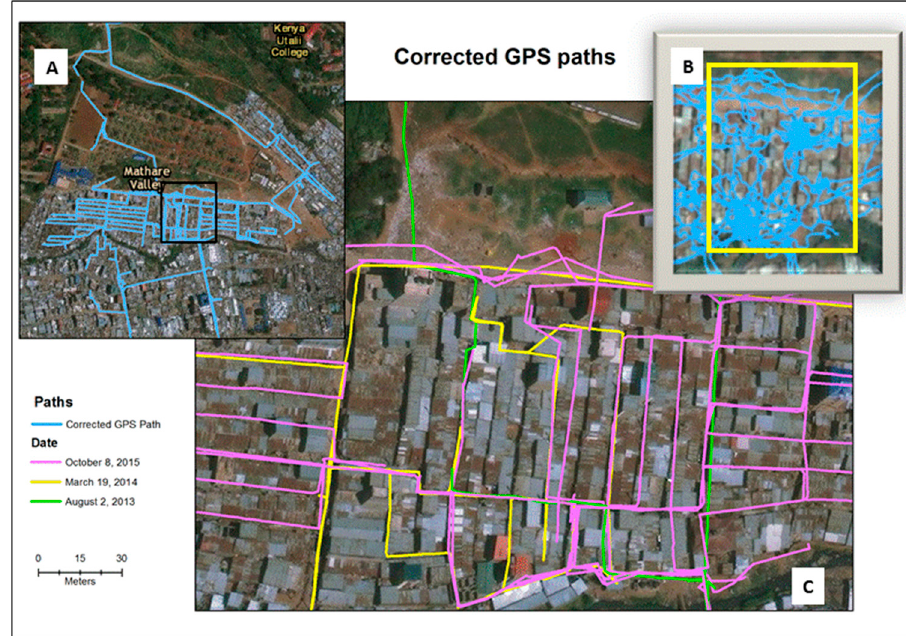
Figure 3 . A map showing all corrected GPS paths for Mathare ( A ), with corrected paths from three time periods ( C ) that coincide with the box in ( A ). ( B ) shows the uncorrected GPS tracks for this same area.